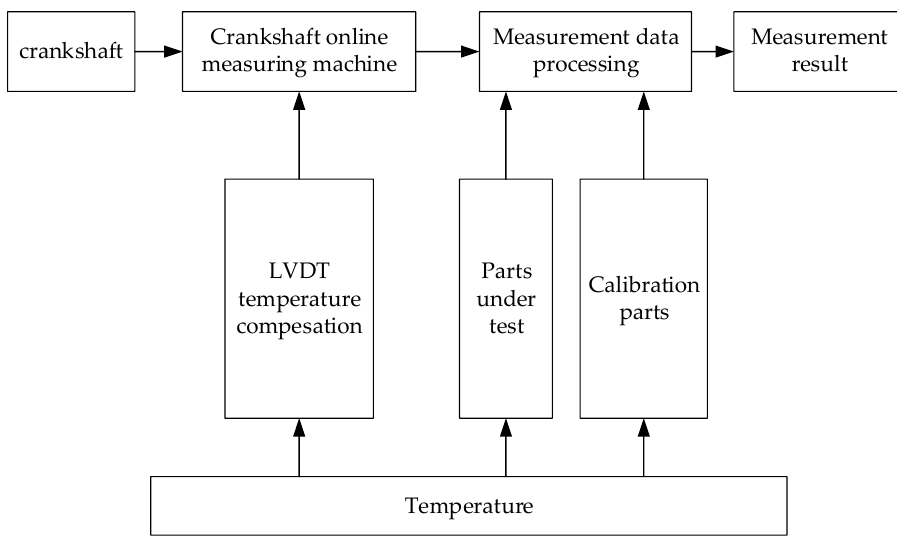
Figure 1. Temperature compensation block